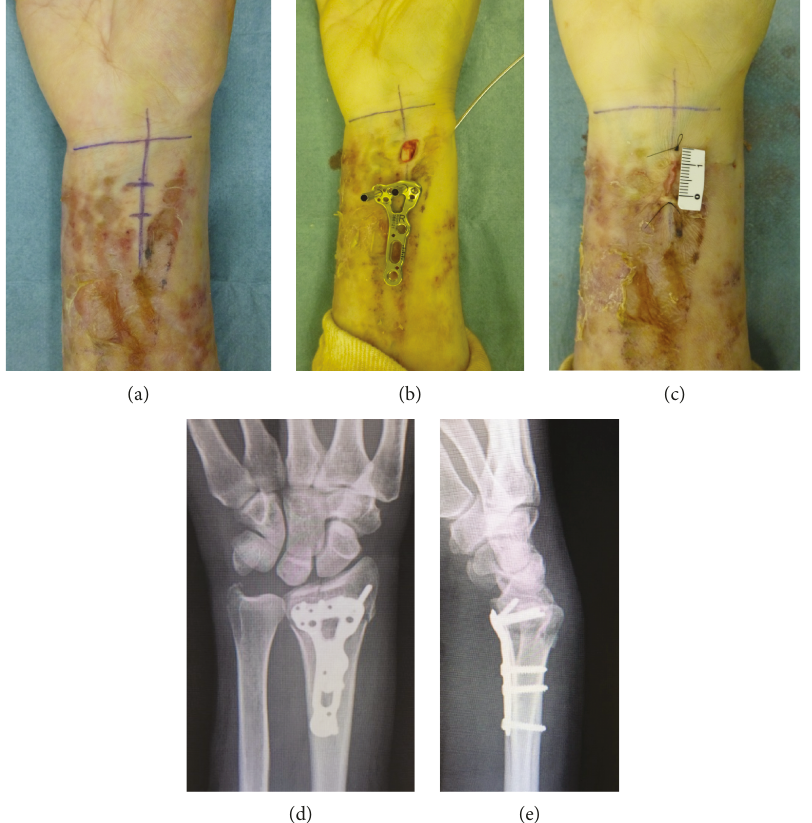
Figure 3: Findings during operation. (a) Skin incision design. This surgical technique could be performed because there was no skin lesion at the skin incision site. (b, c) Volar locking plate fi xation. After reduction of the distal bone fragment using a Kirschner wire, osteosynthesis was performed using a volar locking plate (Acu-Loc 2 proximal plate standard, Nihon Medical Next, Osaka, Japan). (d, e) Plain X-ray images after volar locking plate fi xation ((d): frontal image, (e): lateral image). Fixation in a favorably reduced position is